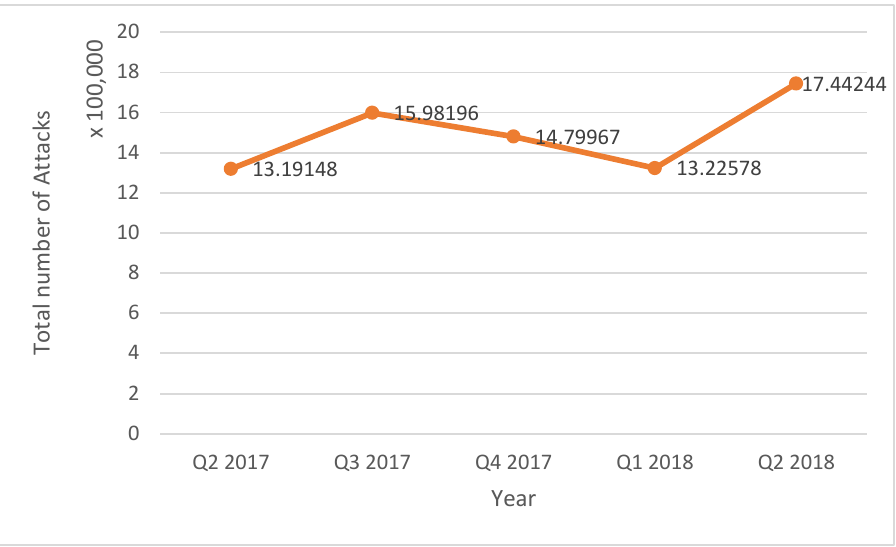
Figure 2. The situation of global mobile threats.